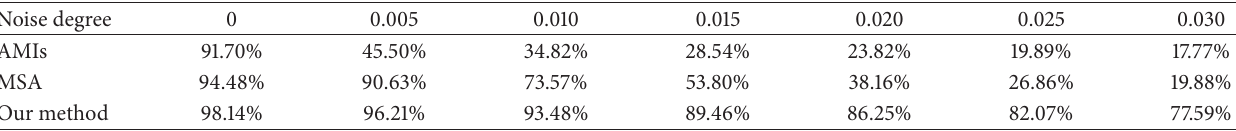
Figure 5: Test characters used in the second experiments. Table 1: Classification accuracies of AMIs, MSA, and the proposed method for Chinese characters in case of affine transformation and different intensities of salt and pepper